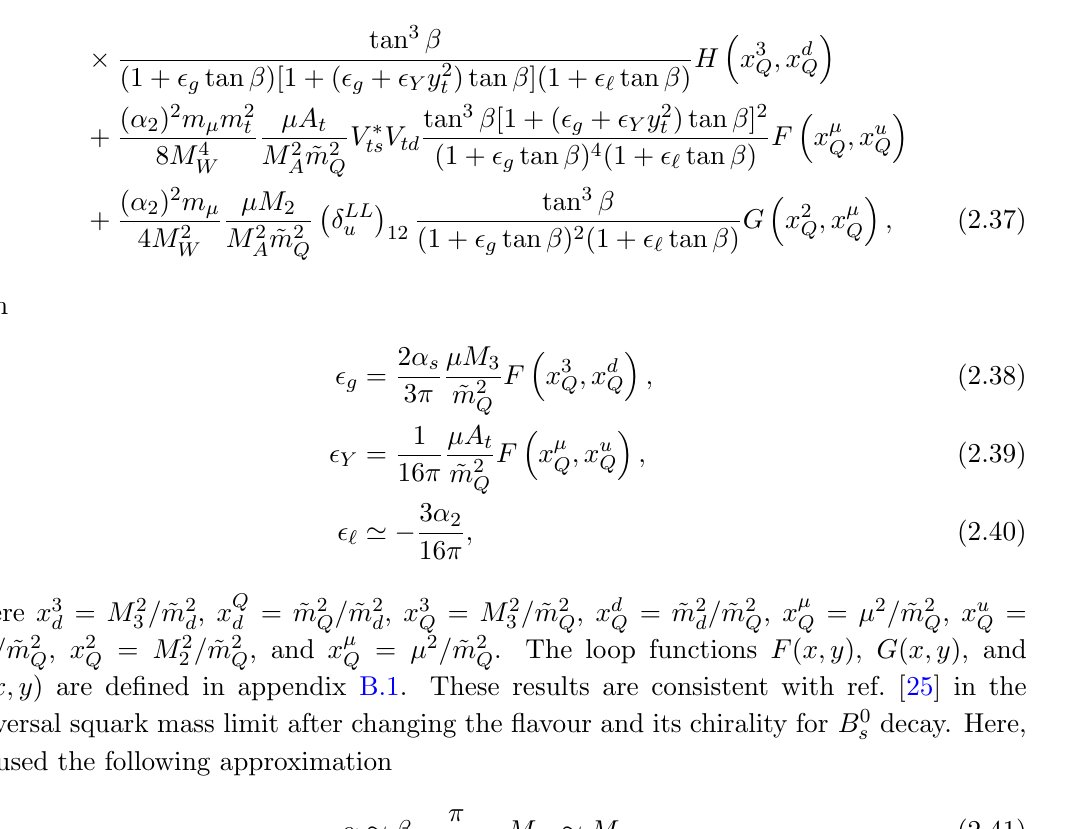
Figure 1 . Feynman diagram of the leading (pseudo-)scalar MSSM contributions to K 0 and K 0 ! (cid:22) + (cid:22) (cid:0) , which include a gluino and a heavy Higgs boson. The black dot is the corre- L sponding mass insertion